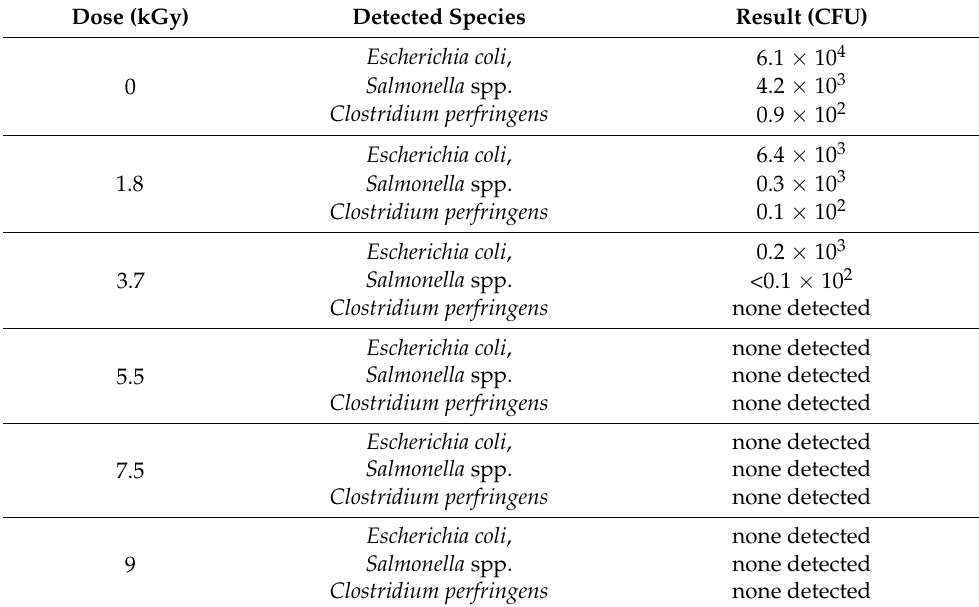
Table 3. Results of the analysis of E.coli , Salmonella spp. and Clostridium perfrigens presence in preliminary sewage sludge from WWTP